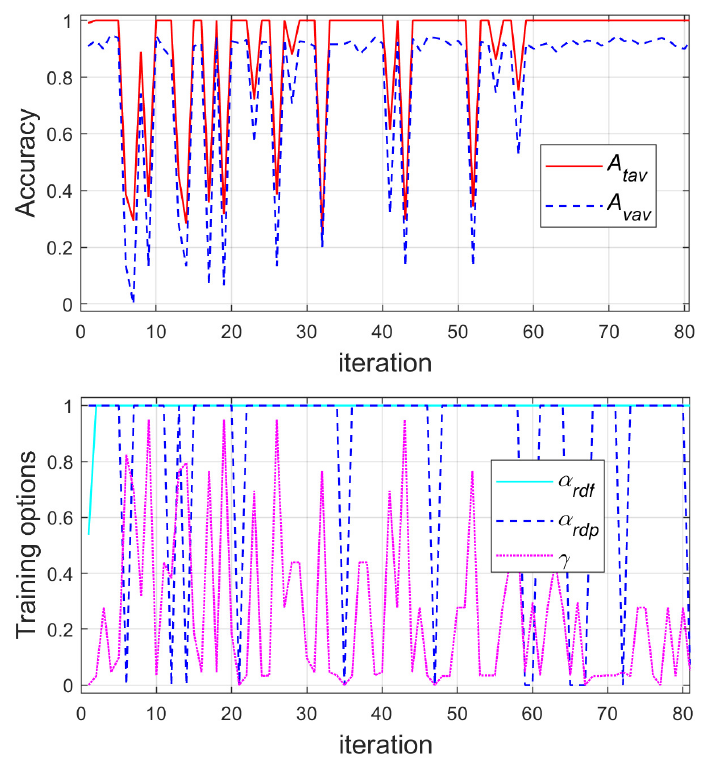
Figure 6. Changes of the average values of training A tav and verification A vav accuracies and the learning rate drop factor α rdf , the learning rate drop period α rdp and the momentum γ of the SGDM during the first 80 iterations of